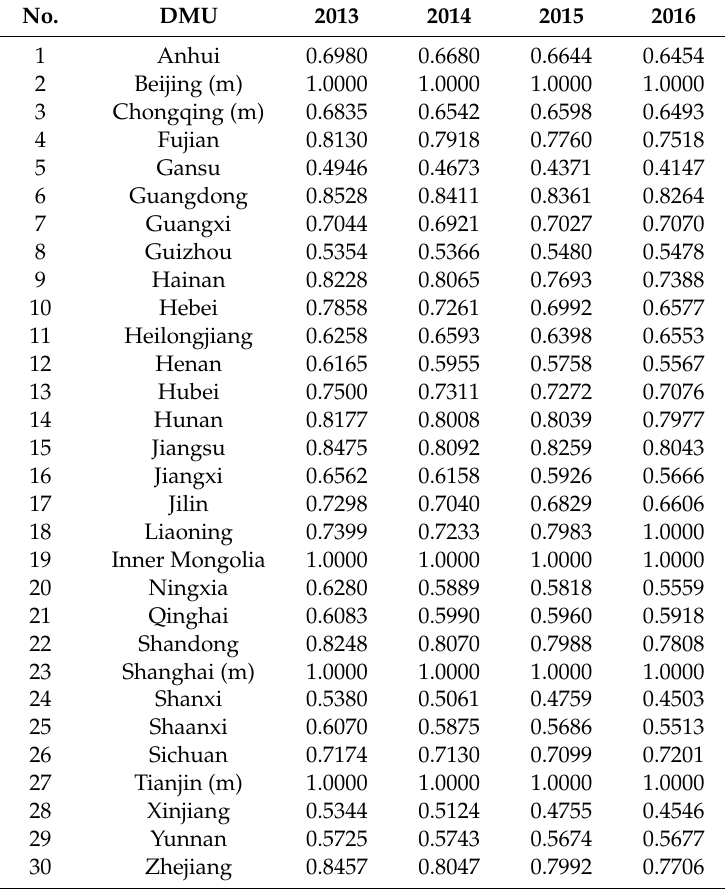
Table 3. E ffi ciency in each municipality (m) / province from 2013–2016. DMU—decision-making unit. No. DMU